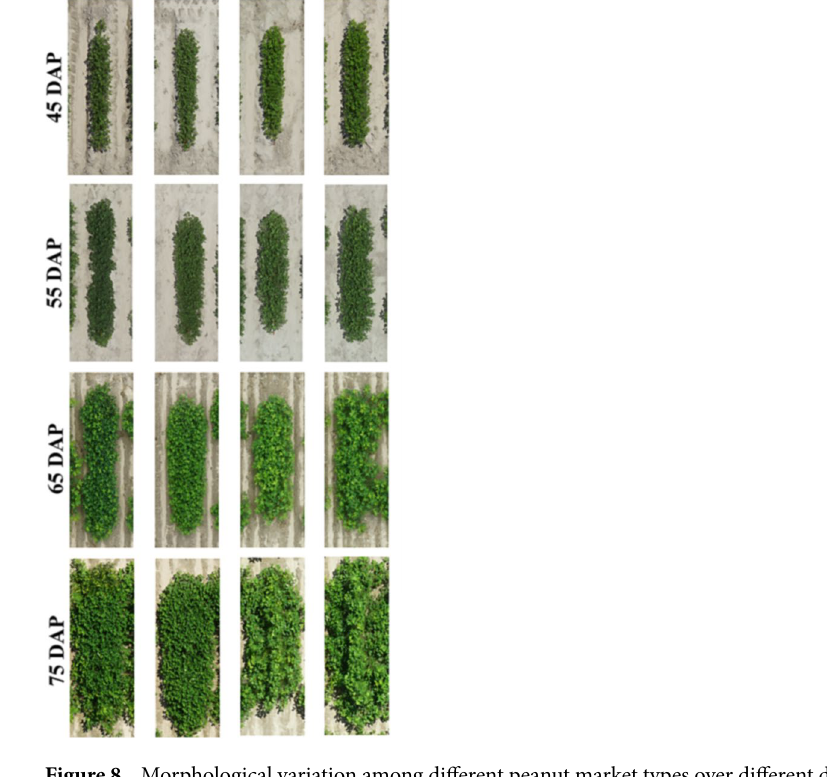
Figure 8. Morphological variation among different peanut market types over different days after planting (DAP). The differences are distinct at 75 DAP. The runner types are more spread out; Virginia types are moderately spread; Spanish and Valencia types have more erect main stem than the